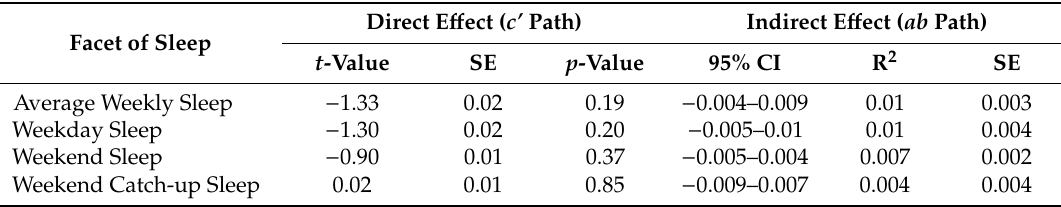
Table 2. Results of Mediation